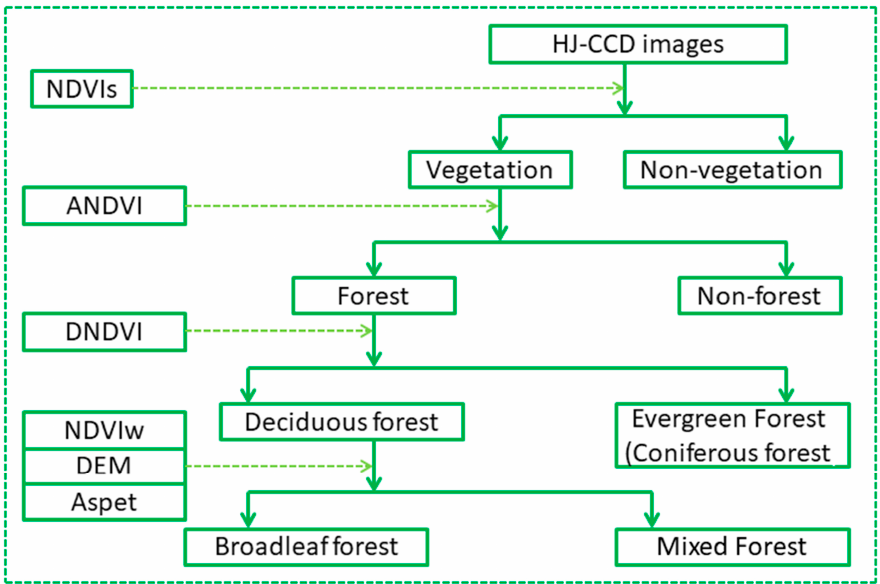
Figure 3. Binary decision tree and classification